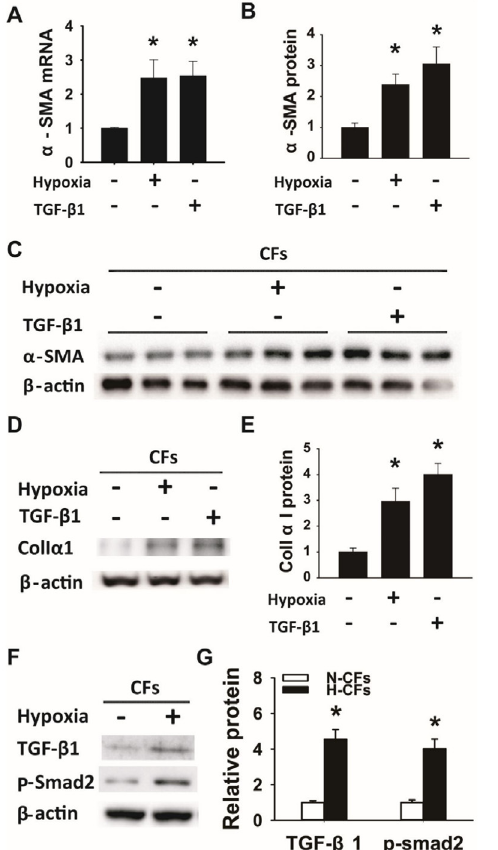
Fig 1. Hypoxia activated cardiac fibroblasts (CFs) to myofibroblasts (MCFs) through TGF- β /Smad2 pathway and increased collagen production. Cardiac fibroblasts cultured at normoxia (N-CFs) and hypoxia condition (H-CFs), or treated with 10 ng/ml TGF- β 1 at normoxia condition 24 hours (N-CFs-TGF- β 1) were collected for subsequent experiments. (A) α -SMA mRNA level measured by qRT-PCR of total RNA isolated from CFs. mRNA value of H-CFs and N-CFs-TGF- β 1 was normalized to N-CFs. (B) Western blots quantification of α -SMA protein expression in cell lysates from CFs after hypoxia and TGF- β 1 pretreatment. The α -SMA ratios normalized to β -actin in both hypoxia and TGF- β 1 treated groups were compared with the control group. (C) Representative western blot analysis of α -SMA protein expression in CFs cultured under standard condition was used as a control. Both hypoxia and TGF- β 1 treatment for 24 hours increased α -SMA expression. (D) Representative western blot of collagen I α I protein expression in cell lysates from N-CFs, H-CFs and N-CFs-TGF- β 1. Both hypoxia and TGF- β 1 treatment for 24 hours increased collagen I α I expression. (E) Quantification of collagen I α I western blot in D. The ratios of collagen I α I normalized to β -actin in both hypoxia and TGF- β 1 pretreated groups were compared with the normoxia cultured group. (F) Representative western blot of TGF- β 1 and phospho-Smad2 protein expression in N-CFs and H-CFs.